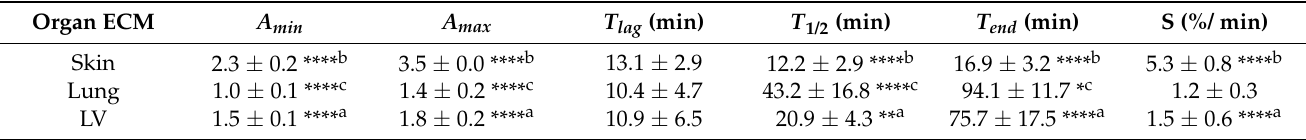
Table 1. Summary of Gelation kinetics parameters for organ derived ECM hydrogels 1 . Organ ECM A min A max Skin Lung